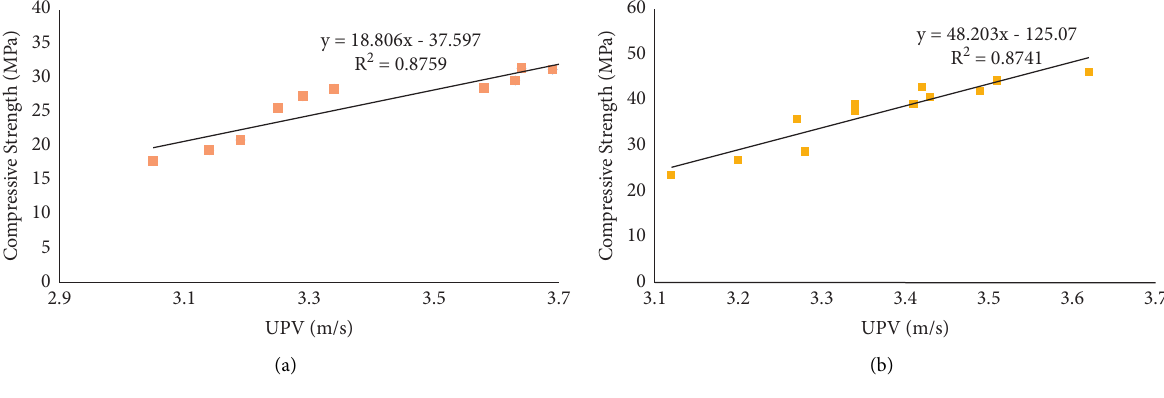
y = 18.806x - 37.597 R 2 = 0.8759